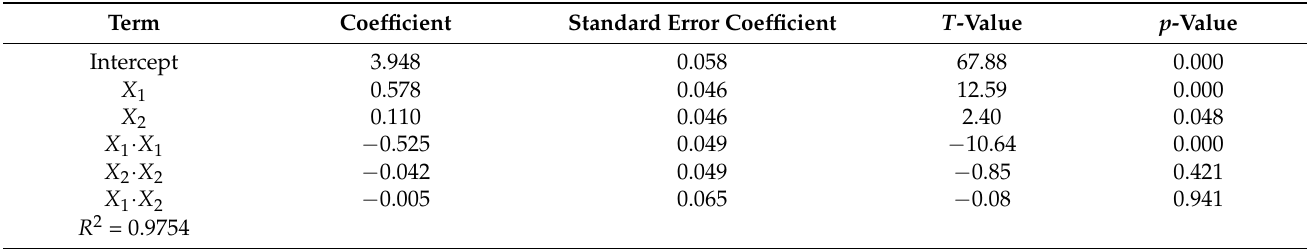
Table 2. The response surface regression coefficients of the polynomial function for the T. distichum needles total extraction yield [%].